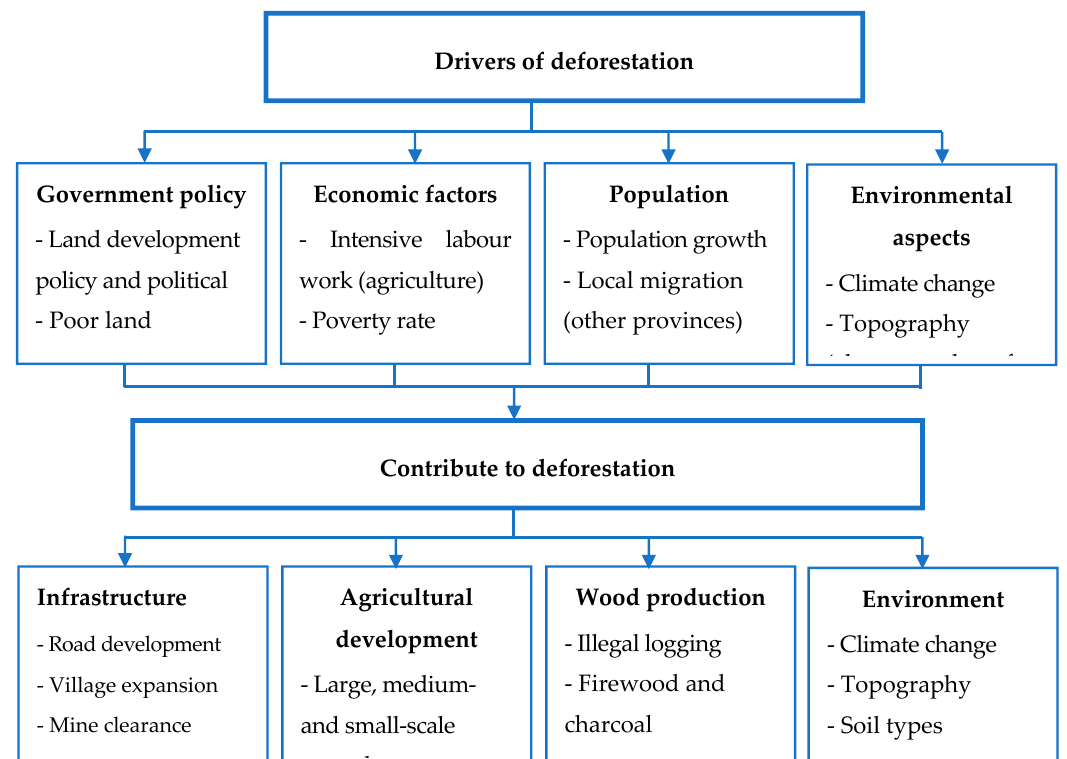
Figure 2. Deforestation drivers in the upstream of Siem Reap